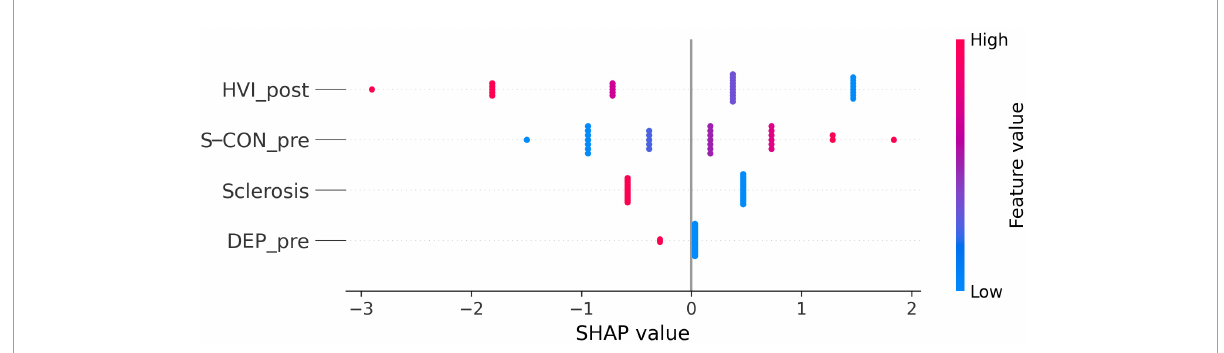
FIGURE11 SHAP influence coefficients computed out of a logistic regressor to predict surgical outcome including only the four highest relevant features (see Supplementary Table 5 ): Hypervigilance Index (HVI) after surgery, Suicide Constellation (S-CON) before surgery, presence of hippocampal sclerosis (Sclerosis), and Depression (DEP_pre) from the clinical interview before surgery. Each dot represents one patient. Negative coefficient correlates with the negative class (Engel I), whereas features with a positive coefficient correlates with the positive class (Engel II or III). This model’s estimated performance is of AUC (Area Under the ROC curve) = 0.8891 (accuracy at 0.85), sensitivity = 0.8653, and specificity =